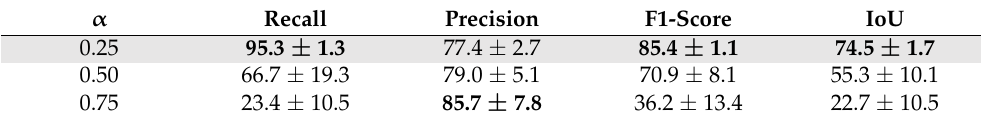
Table 6. Results of analyzing parameter α for U-Net in (%) for the road marking class. α